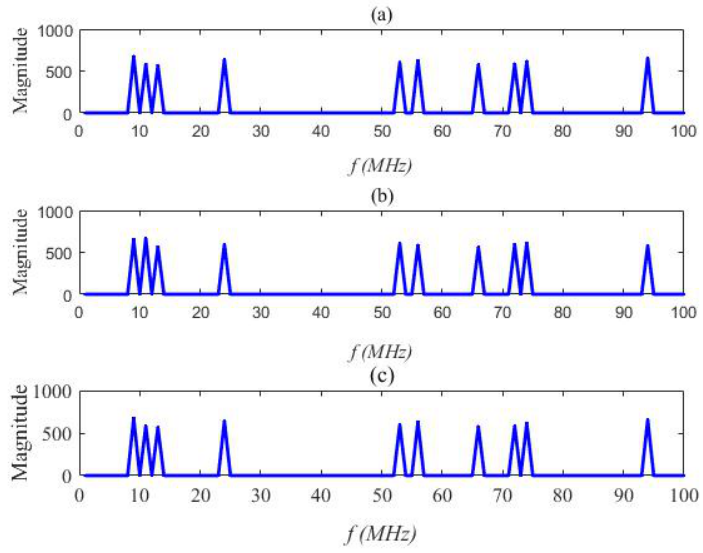
Figure 5. Comparison of the original signal and the STP-CSS reconstructed signal when M = 80. ( a ) The original energy; ( b ) the reconstructed energy of the compressed spectrum sensing algorithm; ( c ) the reconstructed energy of the semi-tensor compressed spectrum sensing